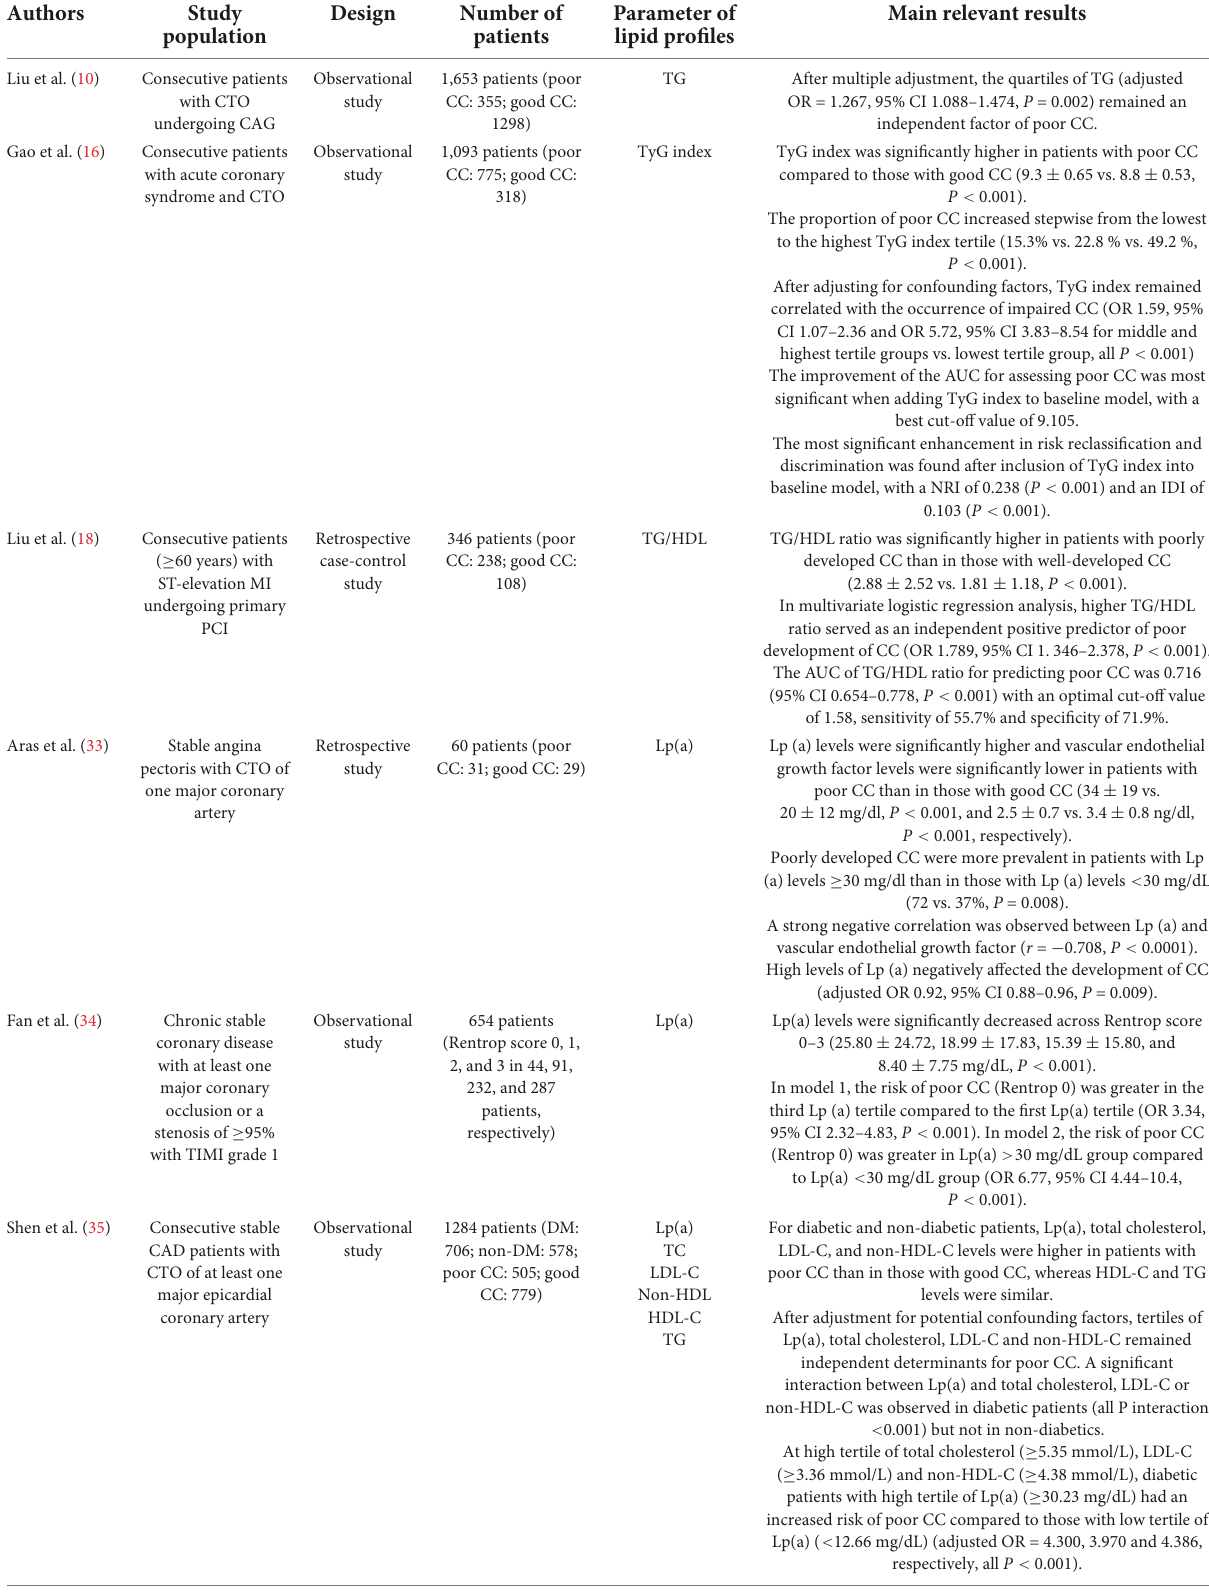
TABLE 1 Summary of clinical studies investigating the association between lipid profiles and coronary collateralization.